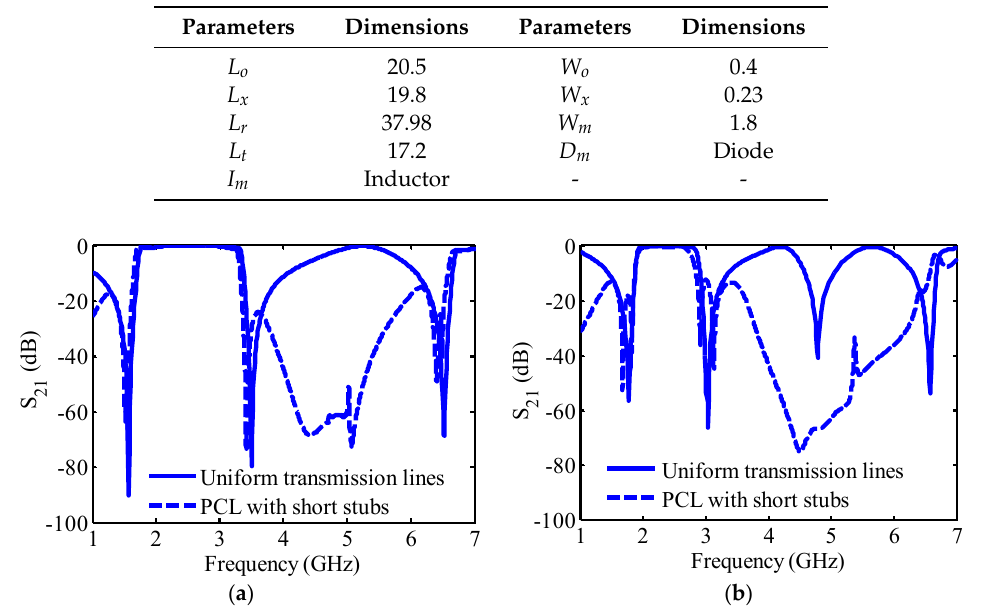
( b ) Figure 9. Proposed reconfigurable bandwidth BPF designs. ( a ) Proposed reconfigurable bandwidth